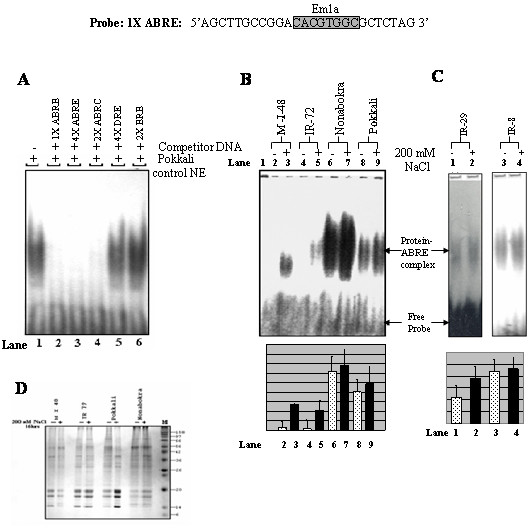
EMSA of 26 bp [32P]-ABRE (Em1a) with the nuclear extract (NE) prepared from lamina of different rice plants & demonstration of the specificity of binding of DNA-protein complex formation. A. 100 fold molar excess of non-radioactive 1X ABRE-DNA (lane 2) or 4X ABRE-DNA (lane 3) or 2X-ABRC-DNA (lane 4) or 4X DRE-DNA (lane5) or 2X ERE-DNA (lane 6) was added in the nuclear extracts from Pokkali plants before the addition of probe and incubated for 30 minutes at 25°C. In lane 1, no competitor was added as control. Equal amount of NE was incubated with amount of probe (1μl = 90,000 cpm) at R.T. in all cases. B. Comparative EMSA of the laminar nuclear extract of two salt sensitive, M-I-48 (lane 2, 3) and IR 72 (lane 4, 5) and two salt tolerant, Pokkali (lane 6, 7) and Nonabokra (lane 8, 9) rice plants with [32P]-ABRE-DNA; and the effect of salinity stress to the plants. C. EMSA with nuclear extracts prepared from laminar tissue of control and salt-treated IR-29 (salt sensitive) and IR-8 (moderately salt tolerant) rice cultivars. Histogram drawn from the values obtained by the densitometric scanning of each lane is shown under the autoradiogram. Mean values ± SD of four independent experiments are shown. D. Protein profile of the nuclear extracts (NE) separated by SDS-PAGE followed by staining with Coomassie Brilliant Blue G-250. Molecular weight marker (broad range from New England Biolabs) was loaded in the extreme right side lane.